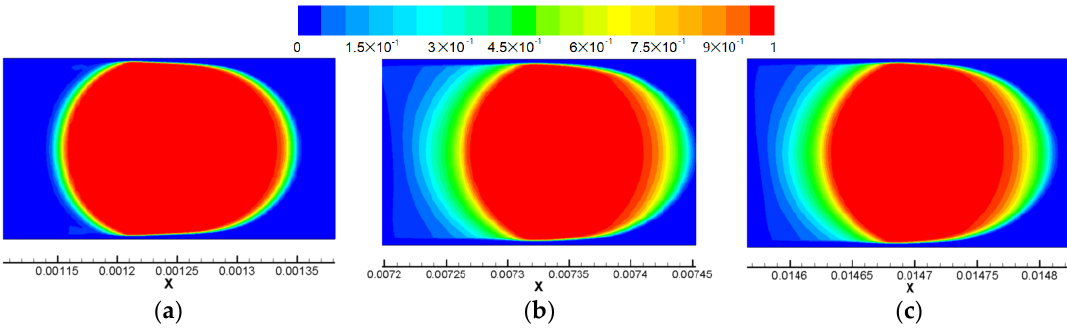
Figure 9. scCO 2 drop at three moments in simulation case 6. ( a ) t = 2.5 ms, L drop,x = (183 ± 4) µm; ( b ) t = 18.235 ms, L drop,x = (155 ± 5) µm; ( c ) t = 37.235 ms, L drop,x = (152.5 ± 3.5) µm. Color map shows the magnitude of the CO 2 volume fraction, in which red color indicates α CO2 = 1.